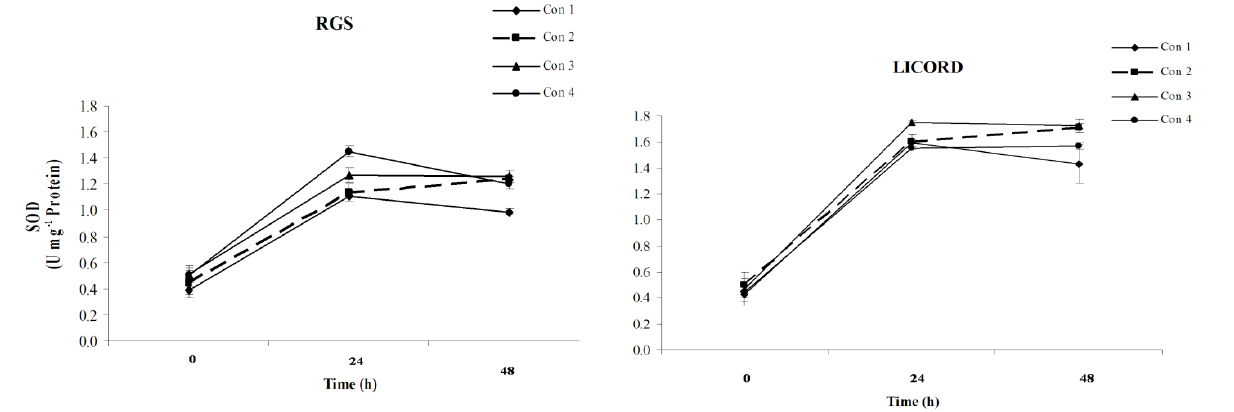
Fig. 3. Effect of different concentration of SA on SOD activity in ‘RGS’ and ‘Licord’ cultivars (Con 1-0 µM/L SA; Con 2-100 µM/L SA; Con 3-200 µM/L SA; Con 4-400 µM/L